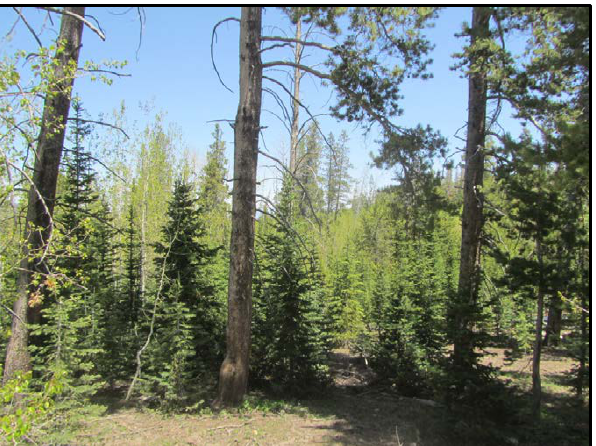
Figure 4. Compared to traditional regeneration treatments in lodgepole pine stands, a shelterwood- with-reserves greatly increases structural, age-class, and species diversity. Maintenance of advance reproduction combined with post-treatment regeneration enhances resistance and resilience to mountain pine beetle attacks for this stand on the Daniel Experimental Forest in Northern